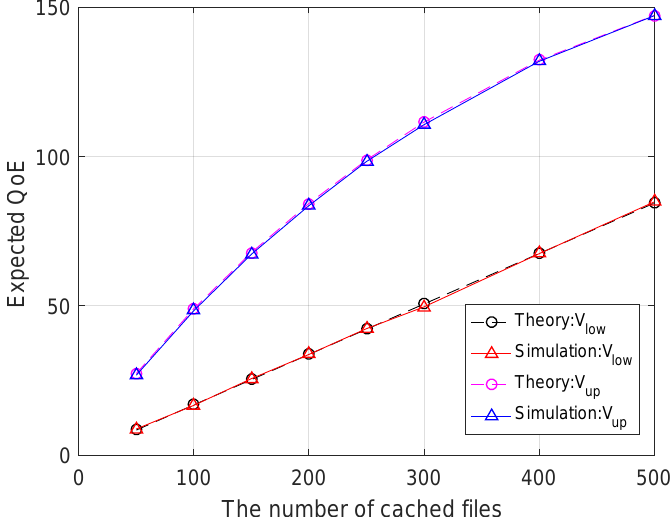
Figure 3. The expected QoE as a function of the number of cached files M